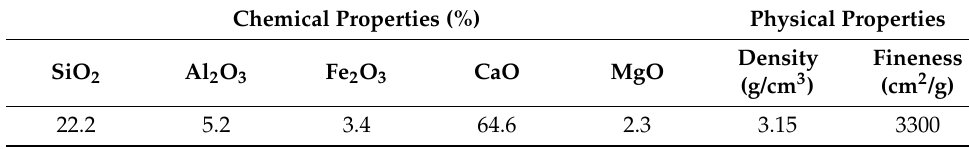
Table 1. Chemical and physical properties of OPC.